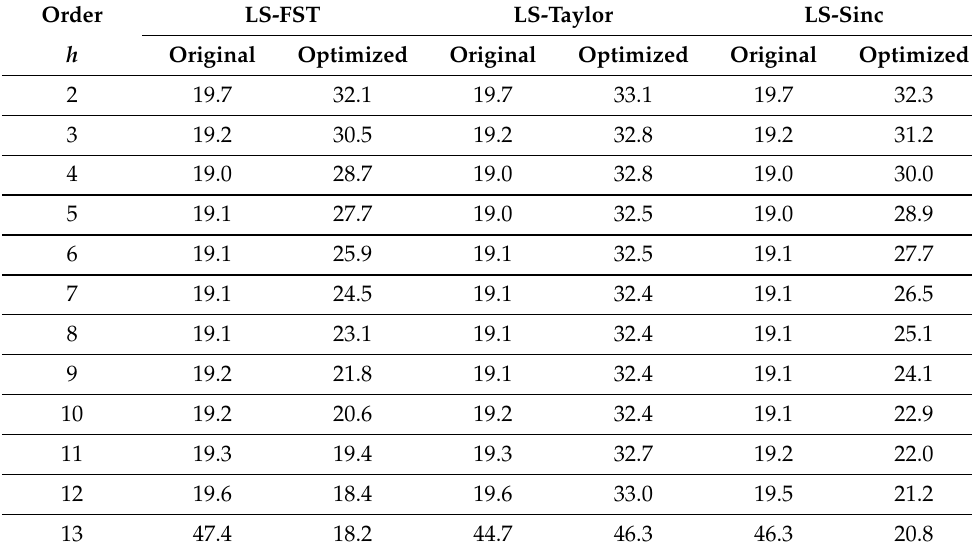
Table 3. The response times of the LS-FST, LS-Taylor, and LS-Sinc with and without the proposed optimization under harmonic phase step